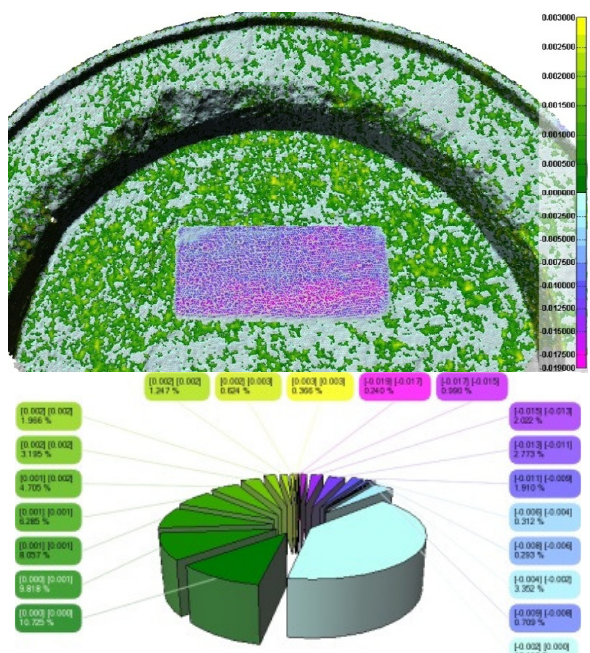
Figure 11. Error map and pie chart for subproject 6 • ICP Alignment (with a max search-distance of 0.01m) stopped after 9 iterations. The convergence reported was below 0.210 nm • Colors represent distance between the two meshes measured along normals to reference. The color scale is set to show distances from -0.02 to +0.003 •